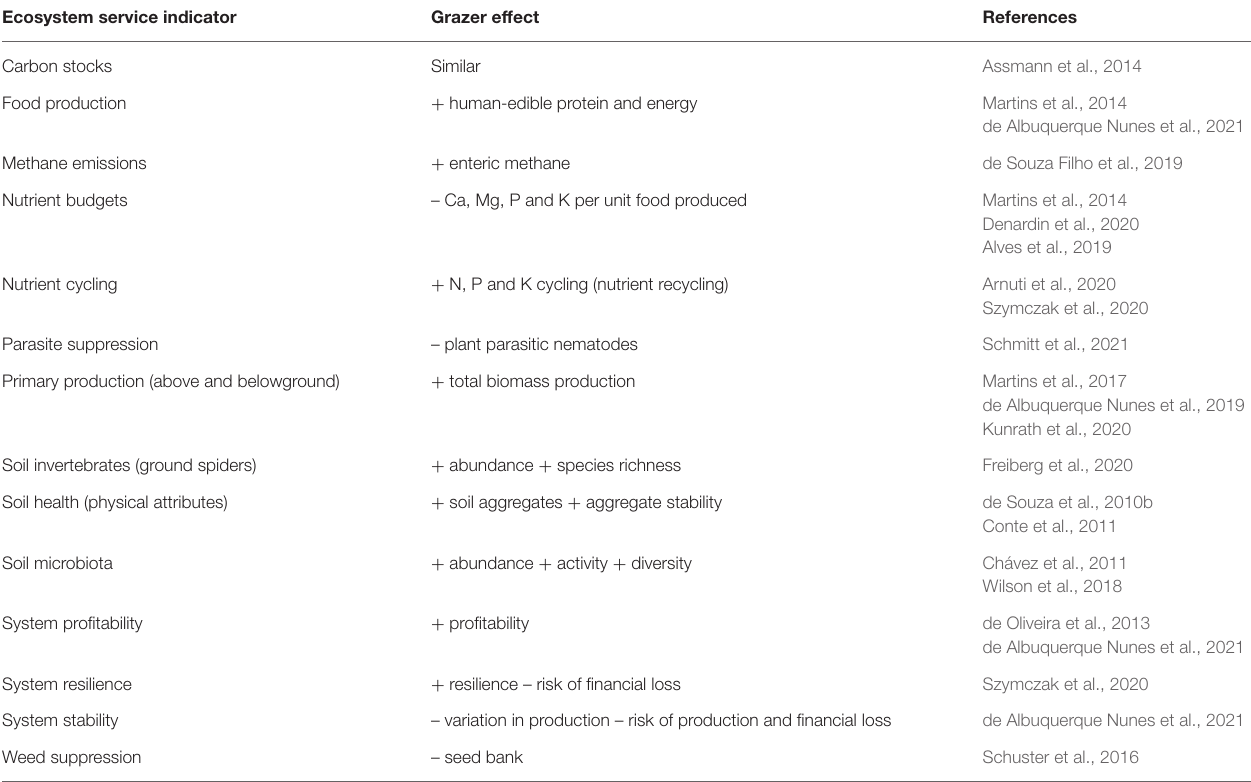
TABLE 1 | Grazer effect at the paddock level and at moderate grazing intensity on ecosystem service indicators. Ecosystem service